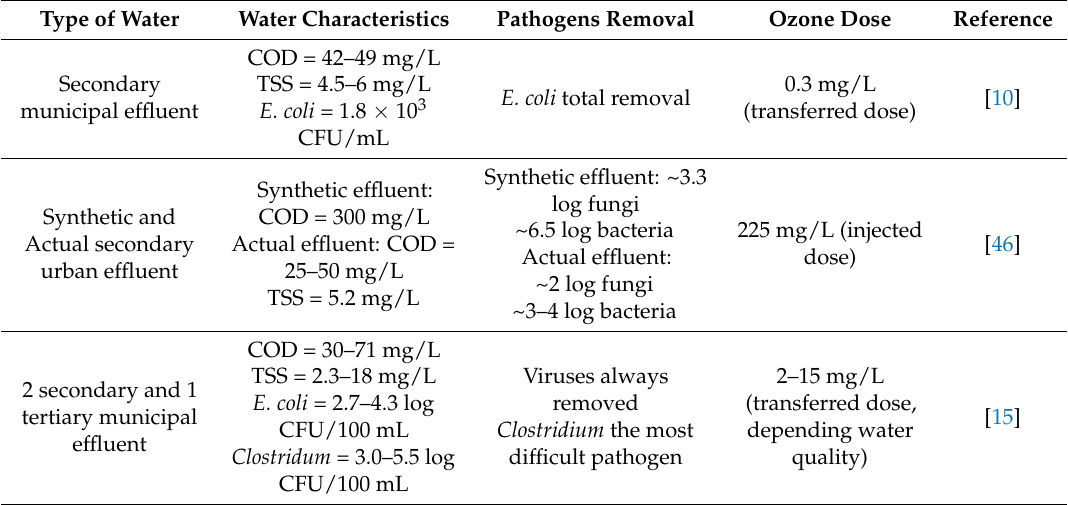
Table 1. Transferred ozone dose (TOD) required for effective disinfection for different water qualities and